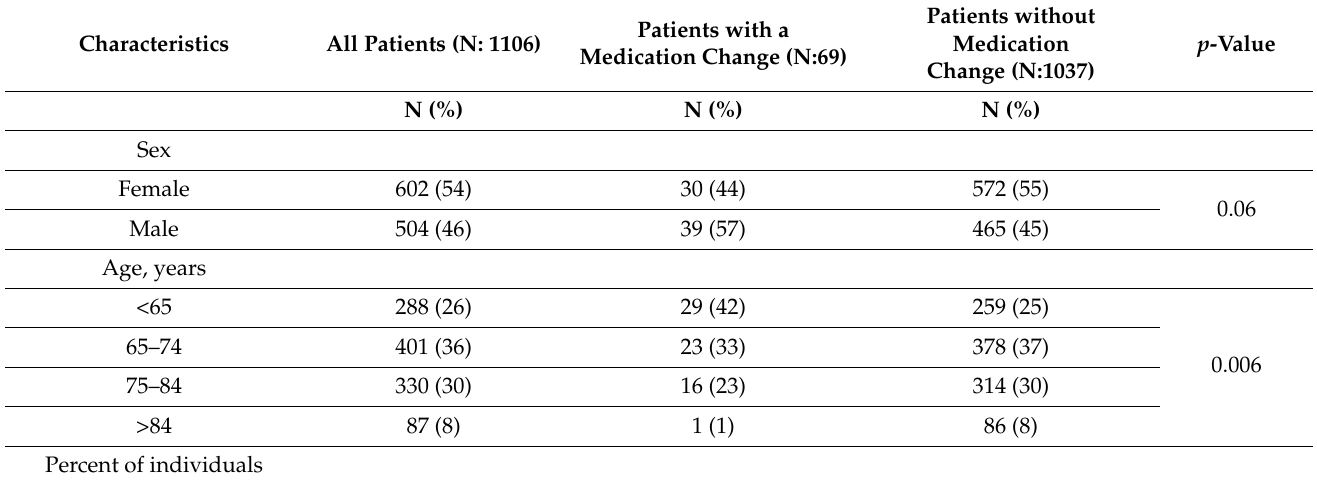
Table 1. Characteristics of patients included in this